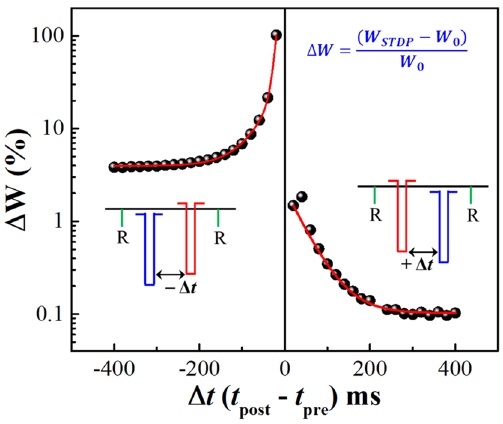
Figure 5. Synaptic weight changes estimated STDP (ΔW %) for both of negative and positive time delays (± Δ t) with a postsynaptic read (− 2.0 V, 10 ms) pulse before and after paired pulse propagation. Insets, schematic representation of temporally correlated presynaptic (− 3.0 V, 2 s) and postsynaptic (− 3.0 V, 2 s) pulses for both the time delay of ± Δ t to probe STDP